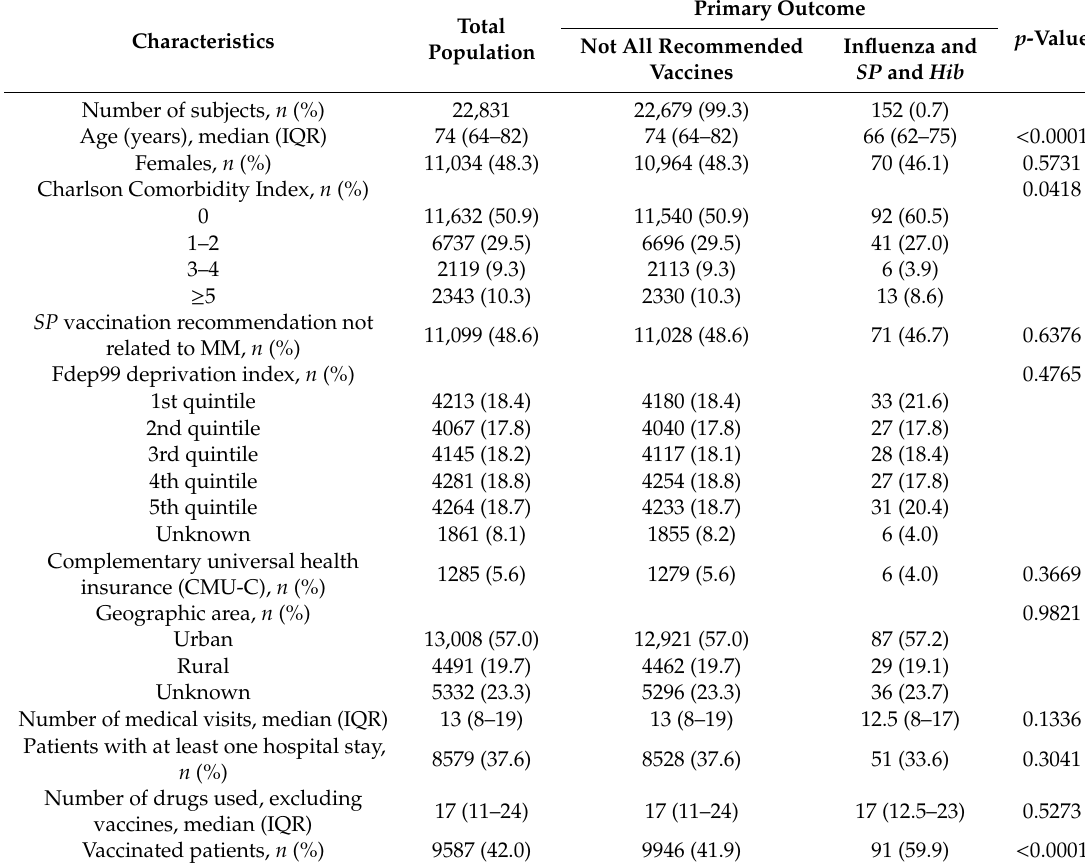
Figure 2. Flowchart of patients included in the study. Table 1. Sociodemographic and medical characteristics of patients during the observation period (12 months before multiple myeloma (MM) diagnosis)—primary outcome.